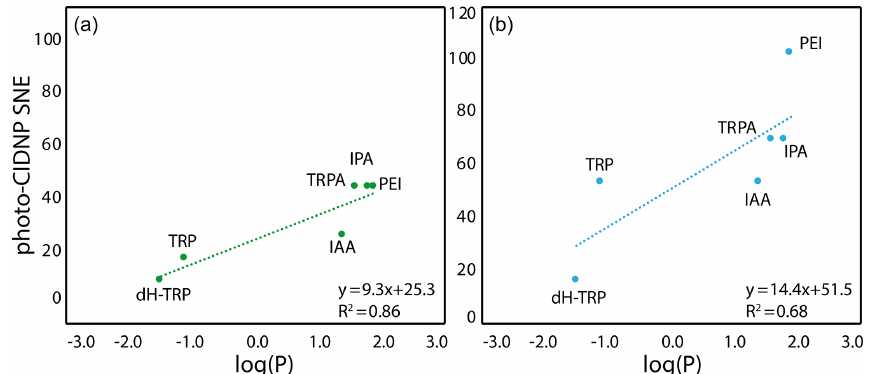
Figure 4. Correlation between the molecule hydrophobicity and the photo-CIDNP performances for the tryptophan derivatives. (a) In the case where CW-photo-CIDNP is monitored by AT12. (b) In the case where CW-photo-CIDNP is monitored by fluorescein. The log( P ) is the logarithm of the partition coefficient, P , between octanol and water, and values were calculated with DataWarrior ® . A statistical analysis of the trend lines using Pearson’s R coefficient and Student’s t test for the hypothesis shows that for AT12 (a) a t of 4.87 and a p value of 0.008 are obtained, and for fluorescein (b) a t of 2.6 and a p value of 0.060 are obtained. Hence, in both cases, the hypothesis H0 (absence of correlation) is rejected, and the alternative hypothesis (correlation is non-null) is